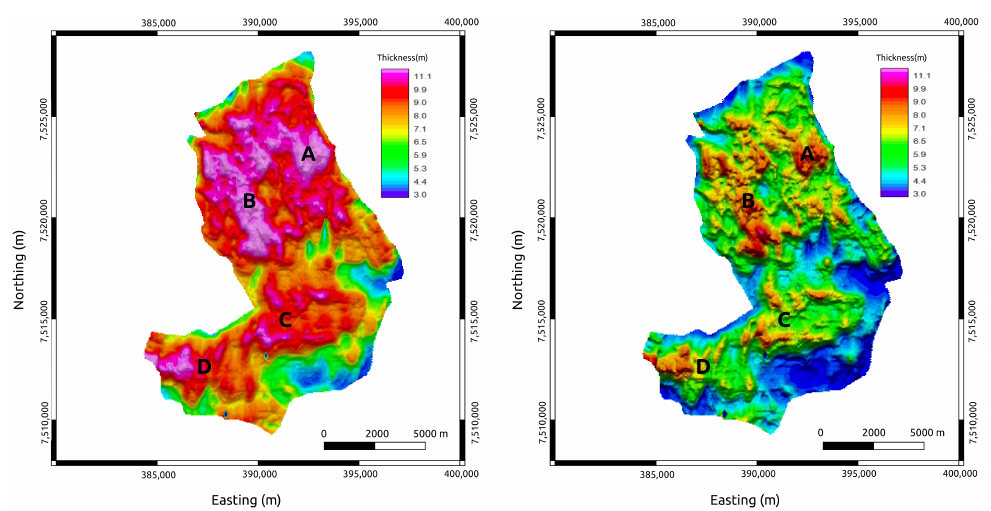
Figure 11. True time-lapse SoPhiH maps of the MR3D reservoir calculated from the flow simulation experiment. ( Left panel ) The base year (2021). ( Right panel ) The monitoring year (2031). A, B, C, and D are anomalous oil zones associated with the reservoir’s thickest portions (Figure 6).